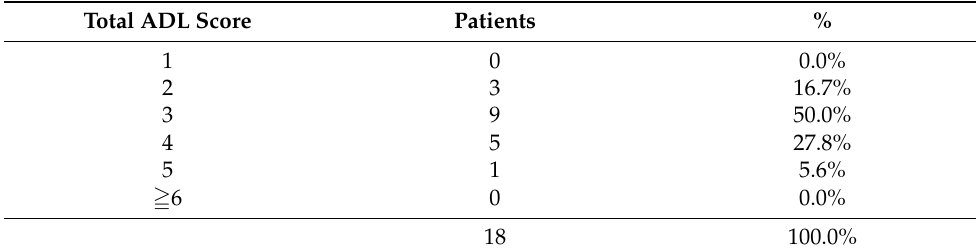
Table 4. Total ADL score of 18 patients evaluated 6 months after